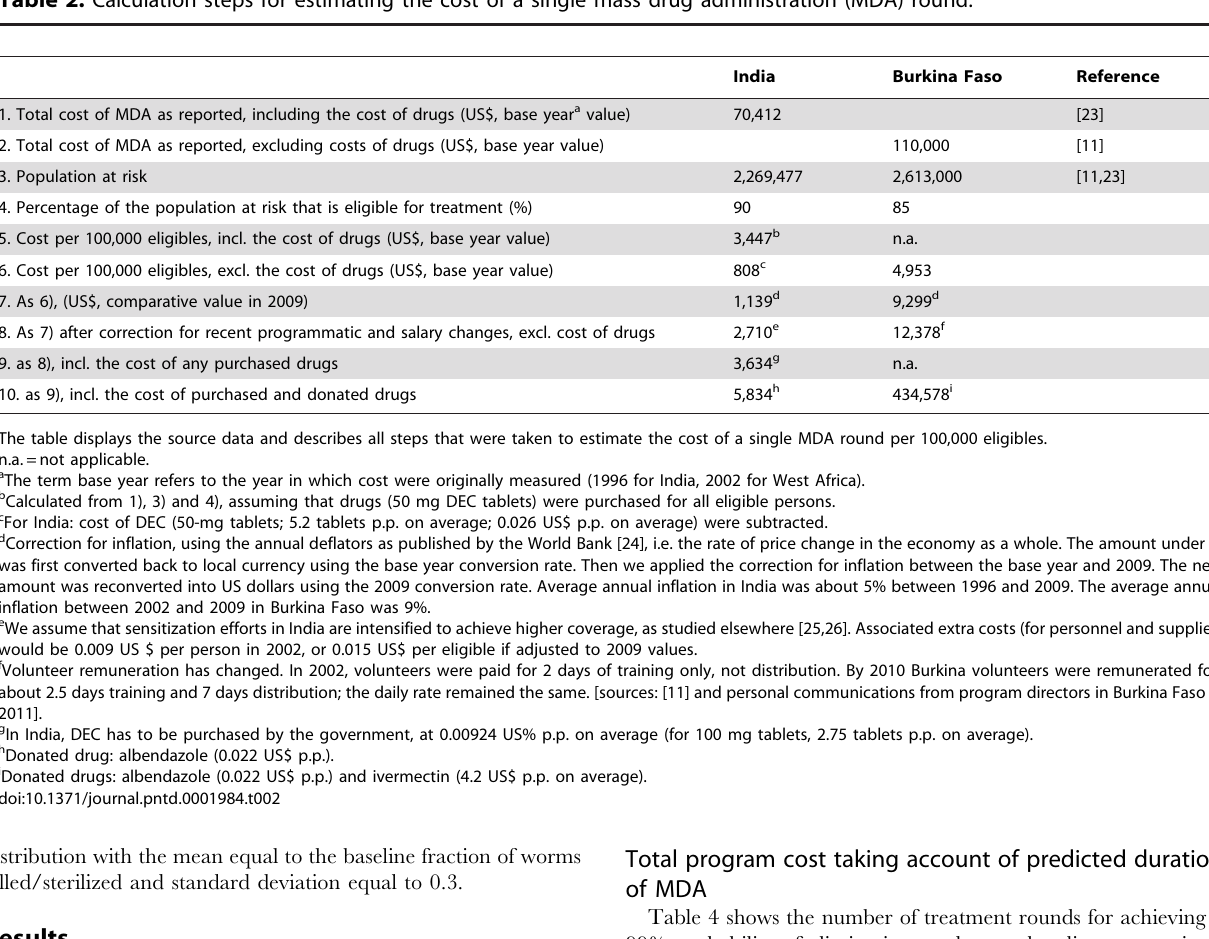
Table 2. Calculation steps for estimating the cost of a single mass drug administration (MDA)